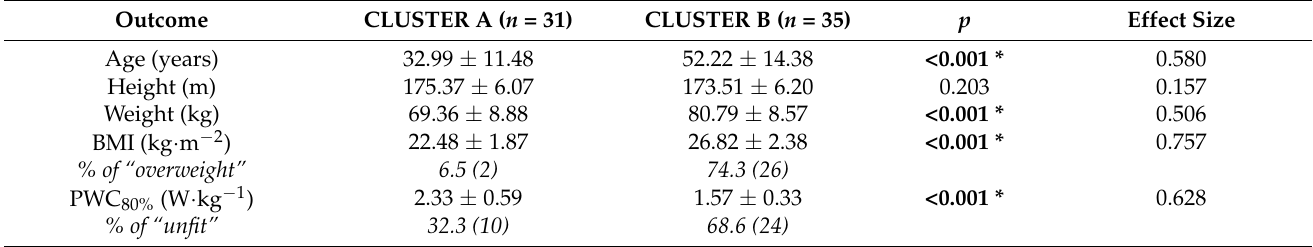
Table 2. Descriptive characteristics of the two cluster groups.